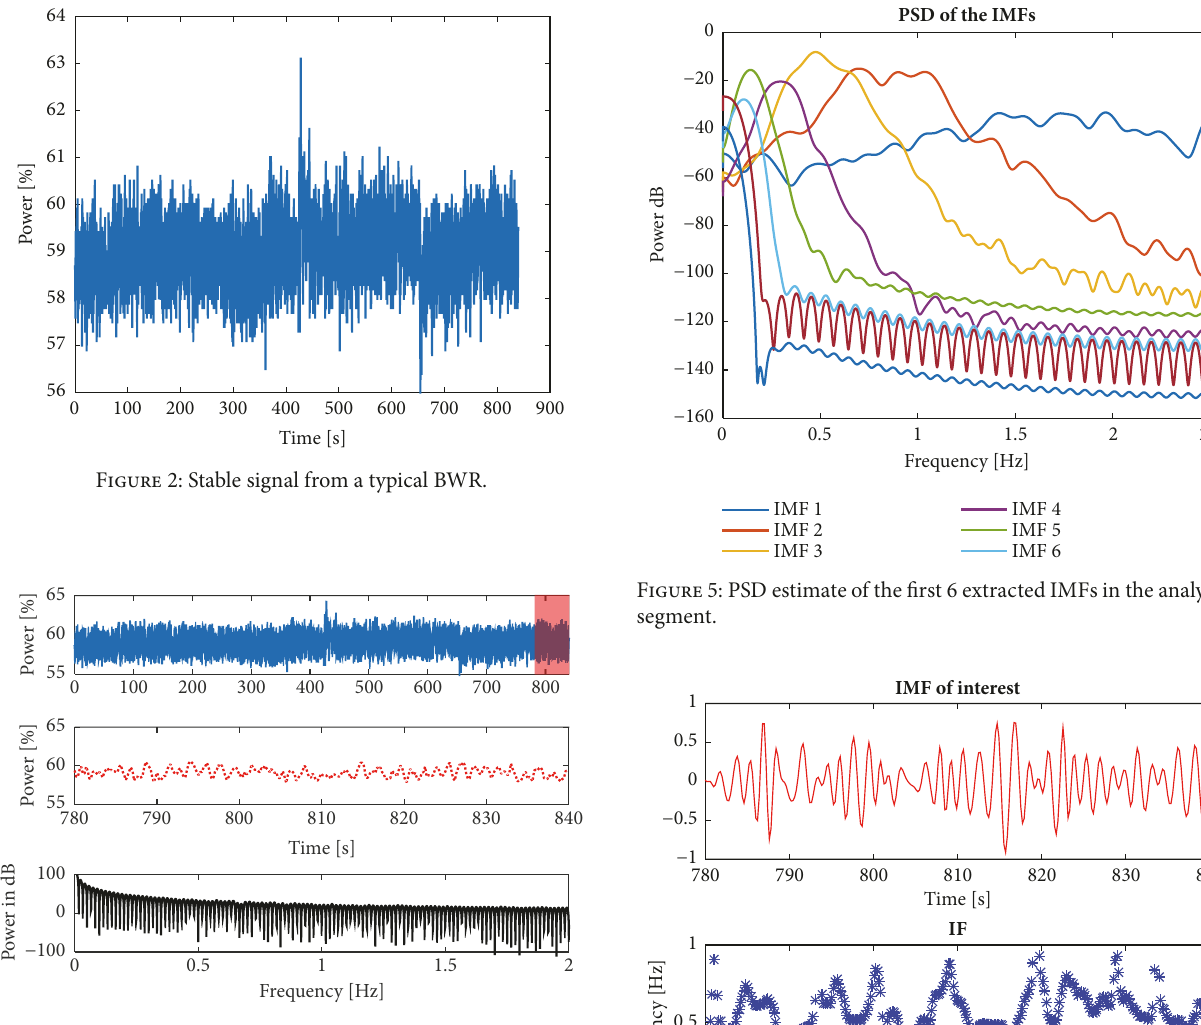
Figure 3: Analyzed segment of the studied APRM signal.